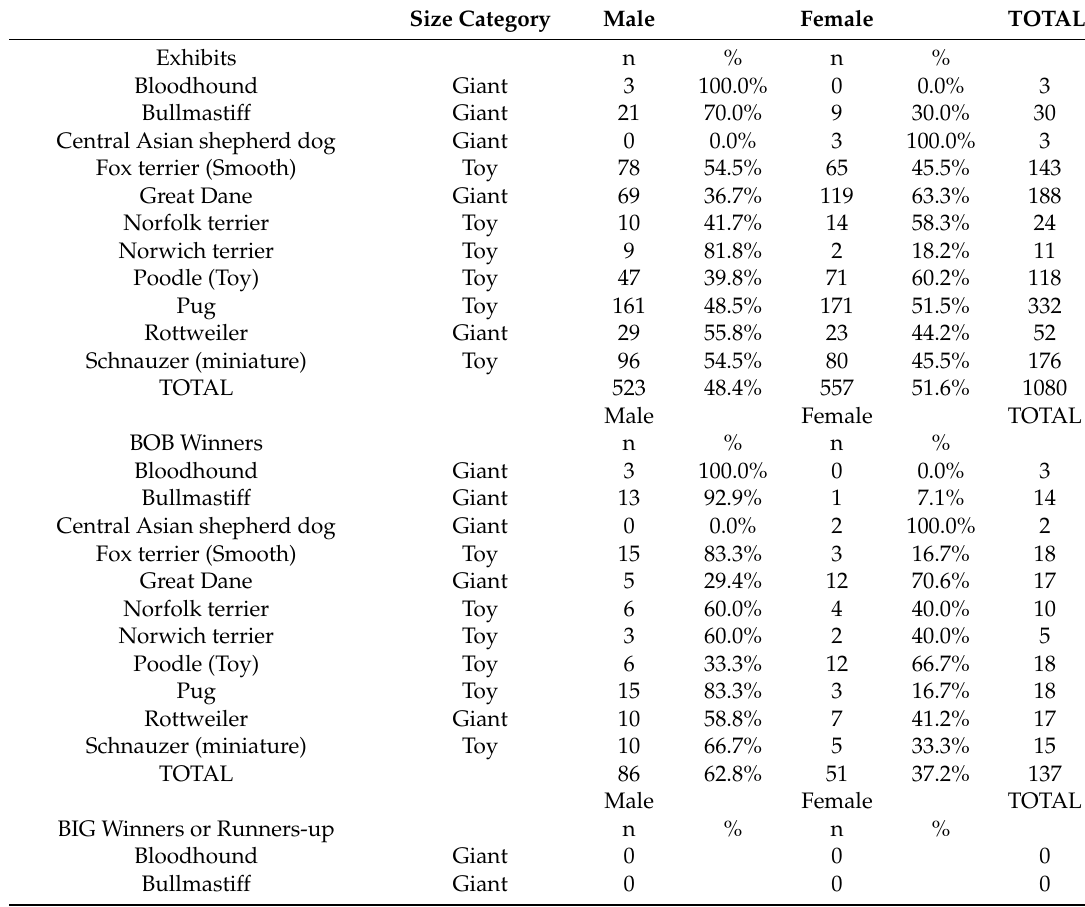
Table 2. The proportional distribution of male and female dogs in Best of Breed (BOB) and Best in Group (BIG) classes in selected NSW dog shows (n = 18) from 2015 to